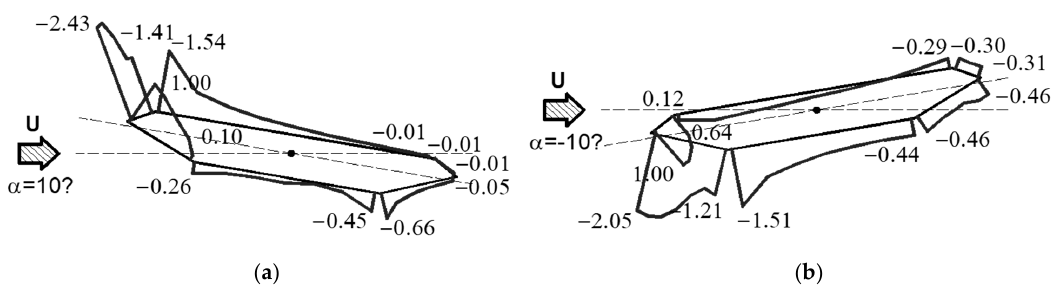
Figure 4. Example of pressure coefficients trend: α = − 10° ( a ) and α = 10° ( b ) [20].